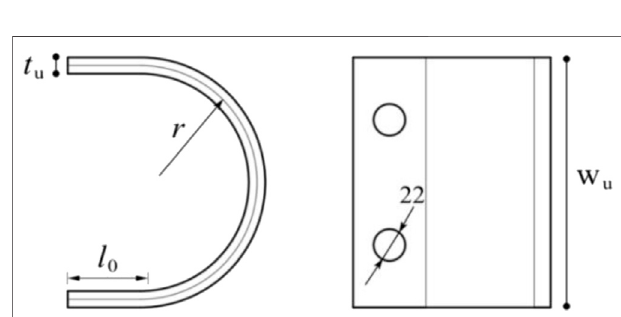
FIGURE 4 | U-shaped damper.